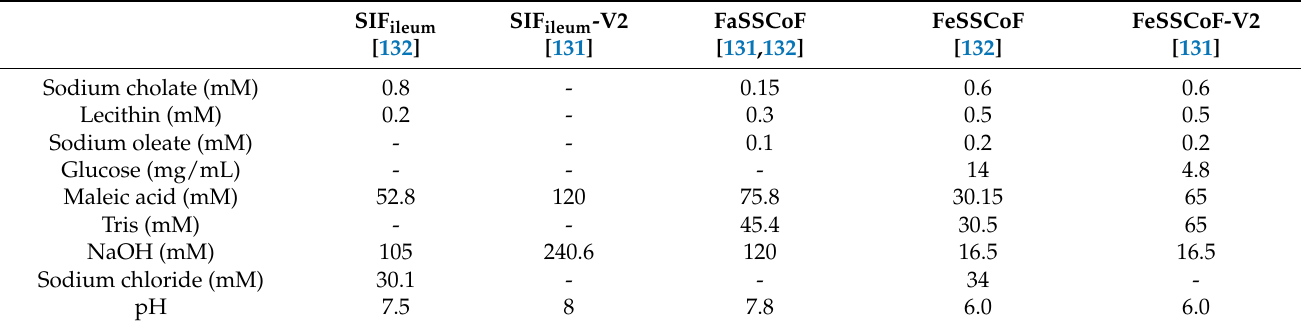
Table 2. Composition of simulating the distal ileum (SIF ileum /SIF ileum -V2), ascending colon in the fasted state (FaSSCoF) and in the fed state